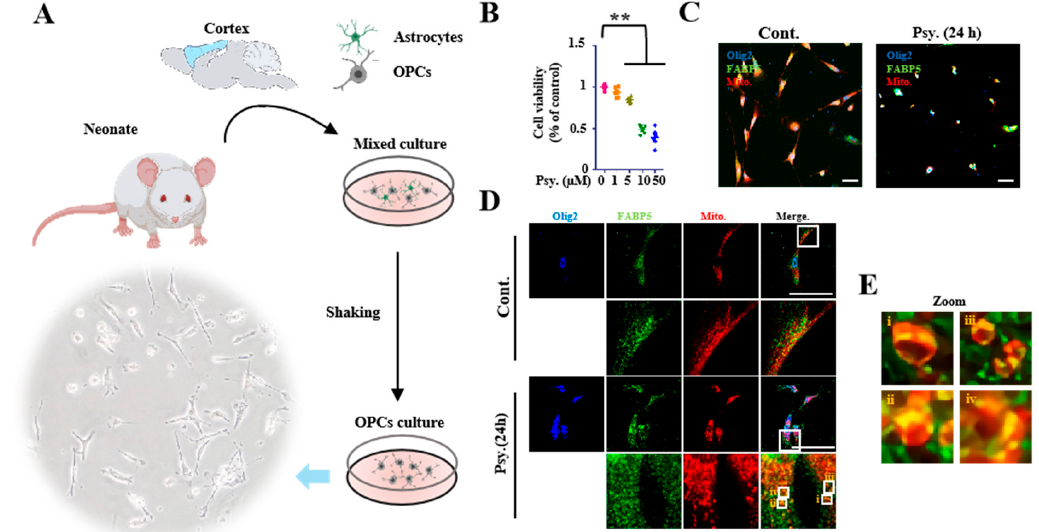
Figure 2. FABP5 localized in mitochondria of OPCs. ( A ) Schematic draft of the primary culture protocol for OPCs. OPCs were isolated from the cortex of neonates and purified by shaking and selective culture. ( B ) Cell viability analysis of OPCs, based on CCK assay. OPCs were treated with psychosine at various concentrations. ( C ) Confocal microscopy of immunofluorescence staining of olig2 (blue), FABP5 (green), Mito-tracker (red). OPCs were treated with psychosine (10 µM) for 24 h. ( D ) Confocal microscopy of OPCs showing FABP5 co-localized with mito-tracker after psychosine treatment. ( E ) Amplified images of mitochondria in ( D ), noise was processed by waifu2x-caffe software (https://github.com/lltcggie/waifu2x-caffe/releases). The data are shown as mean ± standard error of the mean and were obtained using a one-way analysis of variance. ** p < 0.01. Cont., control; psy, psychosine; OPCs, oligodendrocyte precursor cells. Scale bar = 100 µm.